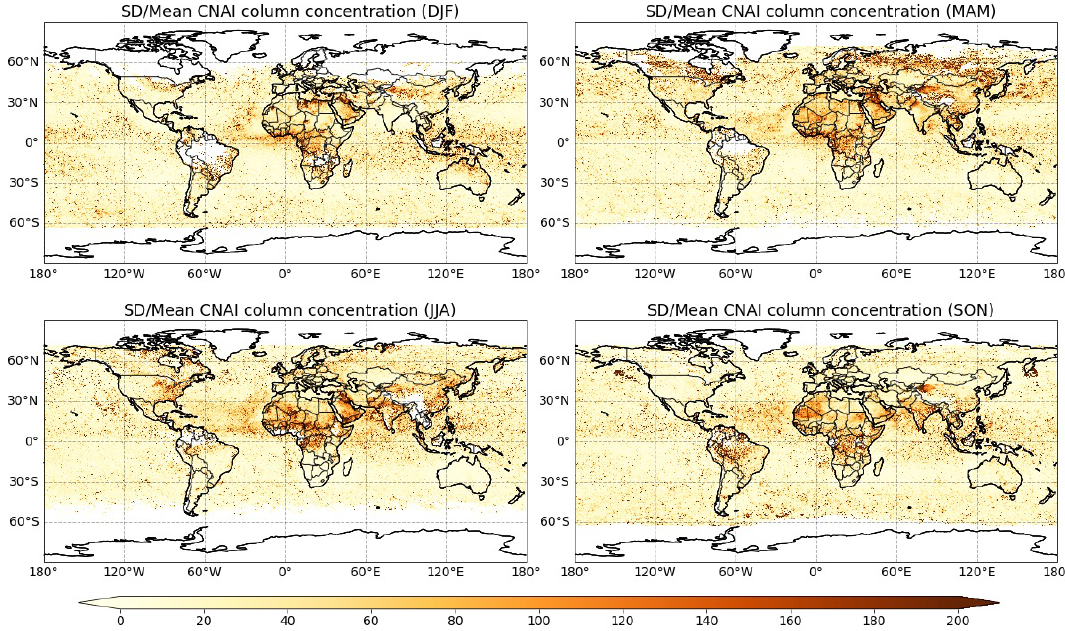
Figure 12. The standard deviation (SD)/mean for seasonal CNAI column mass concentration in Fig. 11 derived from POLDER-3 obser- vations using the GRASP/Component approach. December–January–February (DJF); March–April–May (MAM); June–July–August